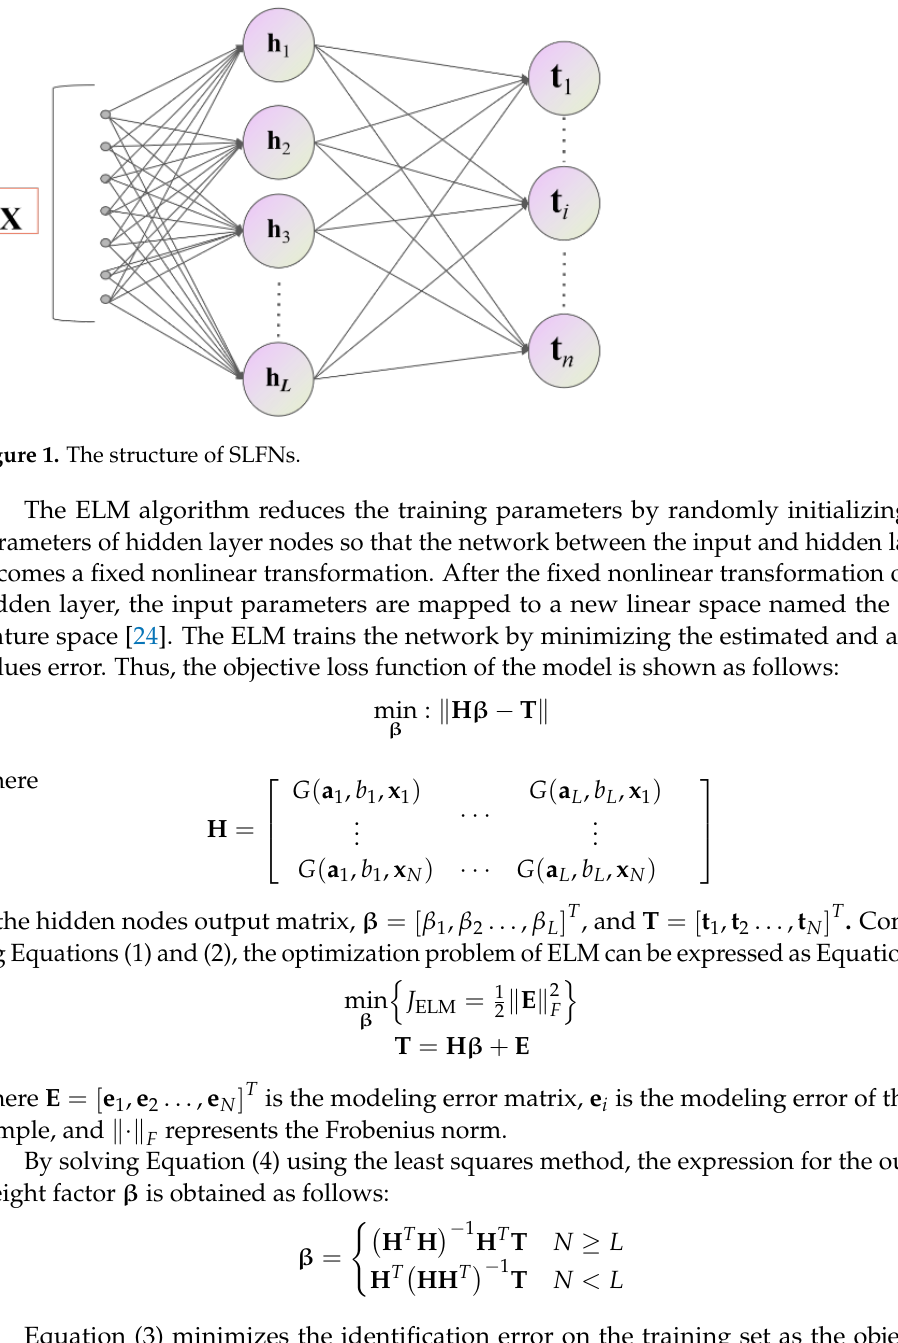
is the hidden nodes output matrix, bining Equations (1) and (2), the optimization problem of ELM can be expressed as Equa- tion (4).